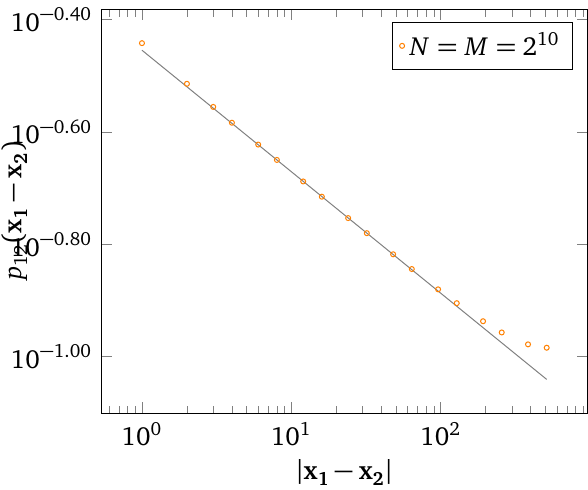
Figure 3: Two-point connectivity (10) for H = − 5 / 8 and N = M = 2 10 . The data points were obtained by averaging over 10 5 instances of the surface and over the N 2 locations of point x (cf. Section 3). According to Table 10, the level h has 1 = − 0.1985. The continuous line shows the prediction (11) with been set to h c = 1.892, see Table 12. For distances 6 < | x − x | < 100 the data matches = D ( 2 ) D f 1 2 f very well with the infinite plane prediction. For larger distances, the effect of the toric boundary conditions becomes